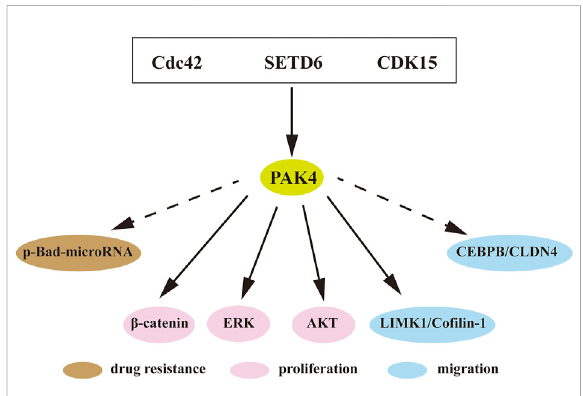
FIGURE 4 PAK4 mediated signaling pathways. Direct or indirect interactions of PAK4 with downstream regulators to control cell proliferation, migration and drug resistance. Cdc42, cell division controlprotein42;SETD6,SET-domaincontainingprotein6; CDK15, cyclin-dependent kinase 15; Bad, Bcl-2-associated death promoter; MEK, mitogen-activated extracellular signal regulated kinase; AKT, protein kinase B; LIMK1, LIM domain kinase 1; CEBPB, CCAAT/enhancer-binding protein β ; CLDN4, Claudin-4. Dotted arrow indicates indirect interaction, solid arrow indicates direct